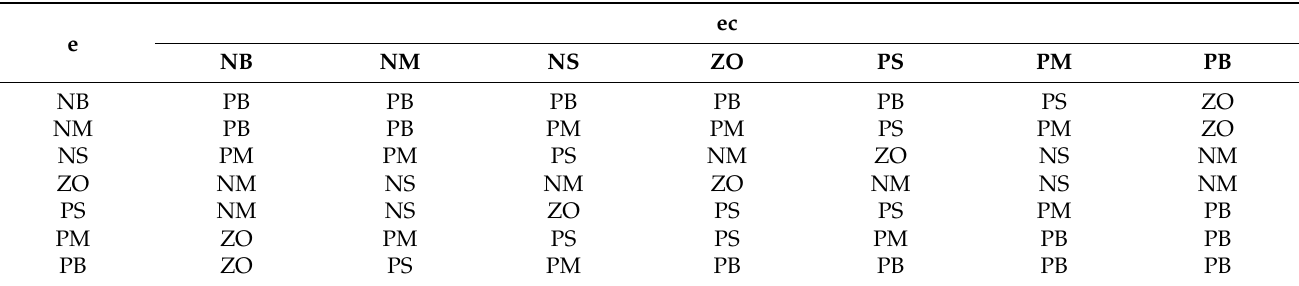
Table 3. ∆ Ki fuzzy inference rule